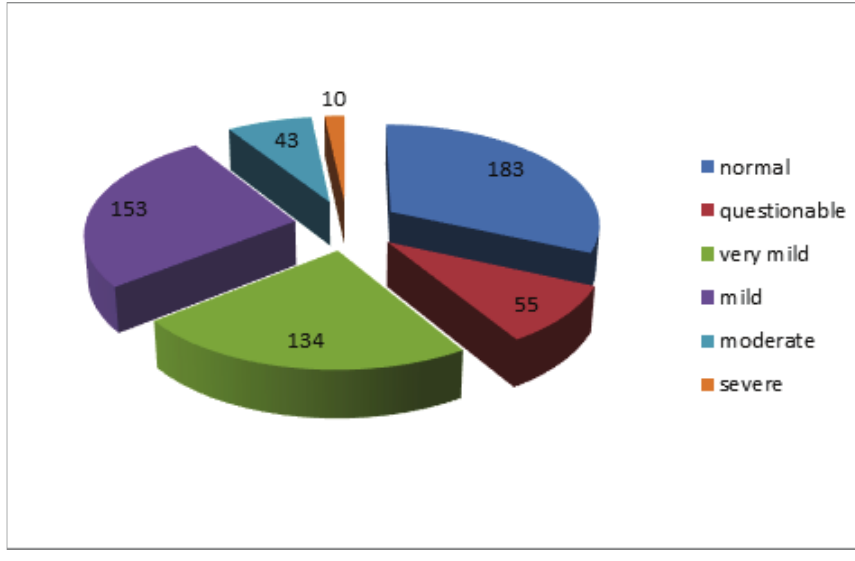
Figure 1 : Prevalence of dental fluorosis among school students.